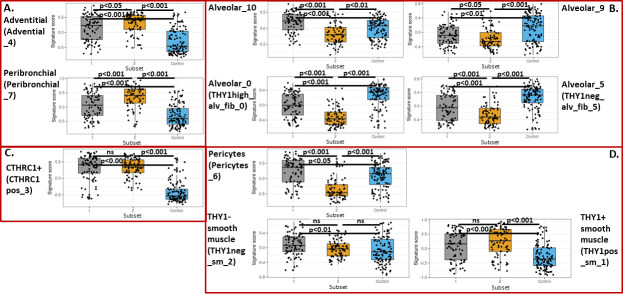
Gene signature scores for smooth muscle/pericyte/fibroblast obtained by using CD45-/EPCAM-/CD235a- (‘Lineage-sorted cells’) data from GSE132771 (Sheppard-UCSF single cell cohort) [19] in GSE47460 (Kaminski-LGRC bulk expression cohort) [14–17] subclasses.Cell cluster names follow labeling in S3B Fig. Labels used in S3B Fig are indicated in parentheses. A. Gene signature scores for adventitial and peribronchial fibroblast subpopulations. B. Gene signature scores for alveolar fibroblast subpopulations. C. Gene signature scores for CTHRC1+ fibroblast subpopulation. D. Gene expression scores for pericytes and smooth muscle cell populations. Adjusted p values are reported on plots.